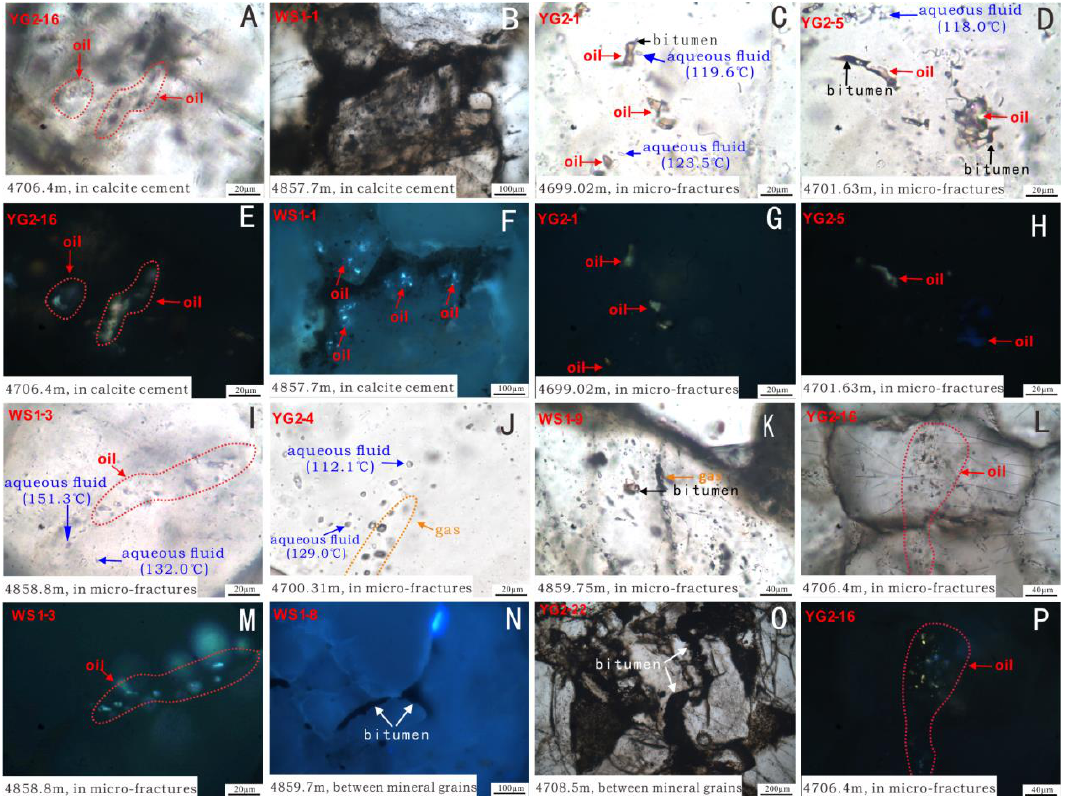
Figure 3. Photos of inclusions and bitumen in the Permian reservoir of the Wumaying buried hill. The well where the inclusion is located, sample depth, inclusion capture location, inclusion type, and homogenization temperature of aqueous inclusion are indicated in each image.